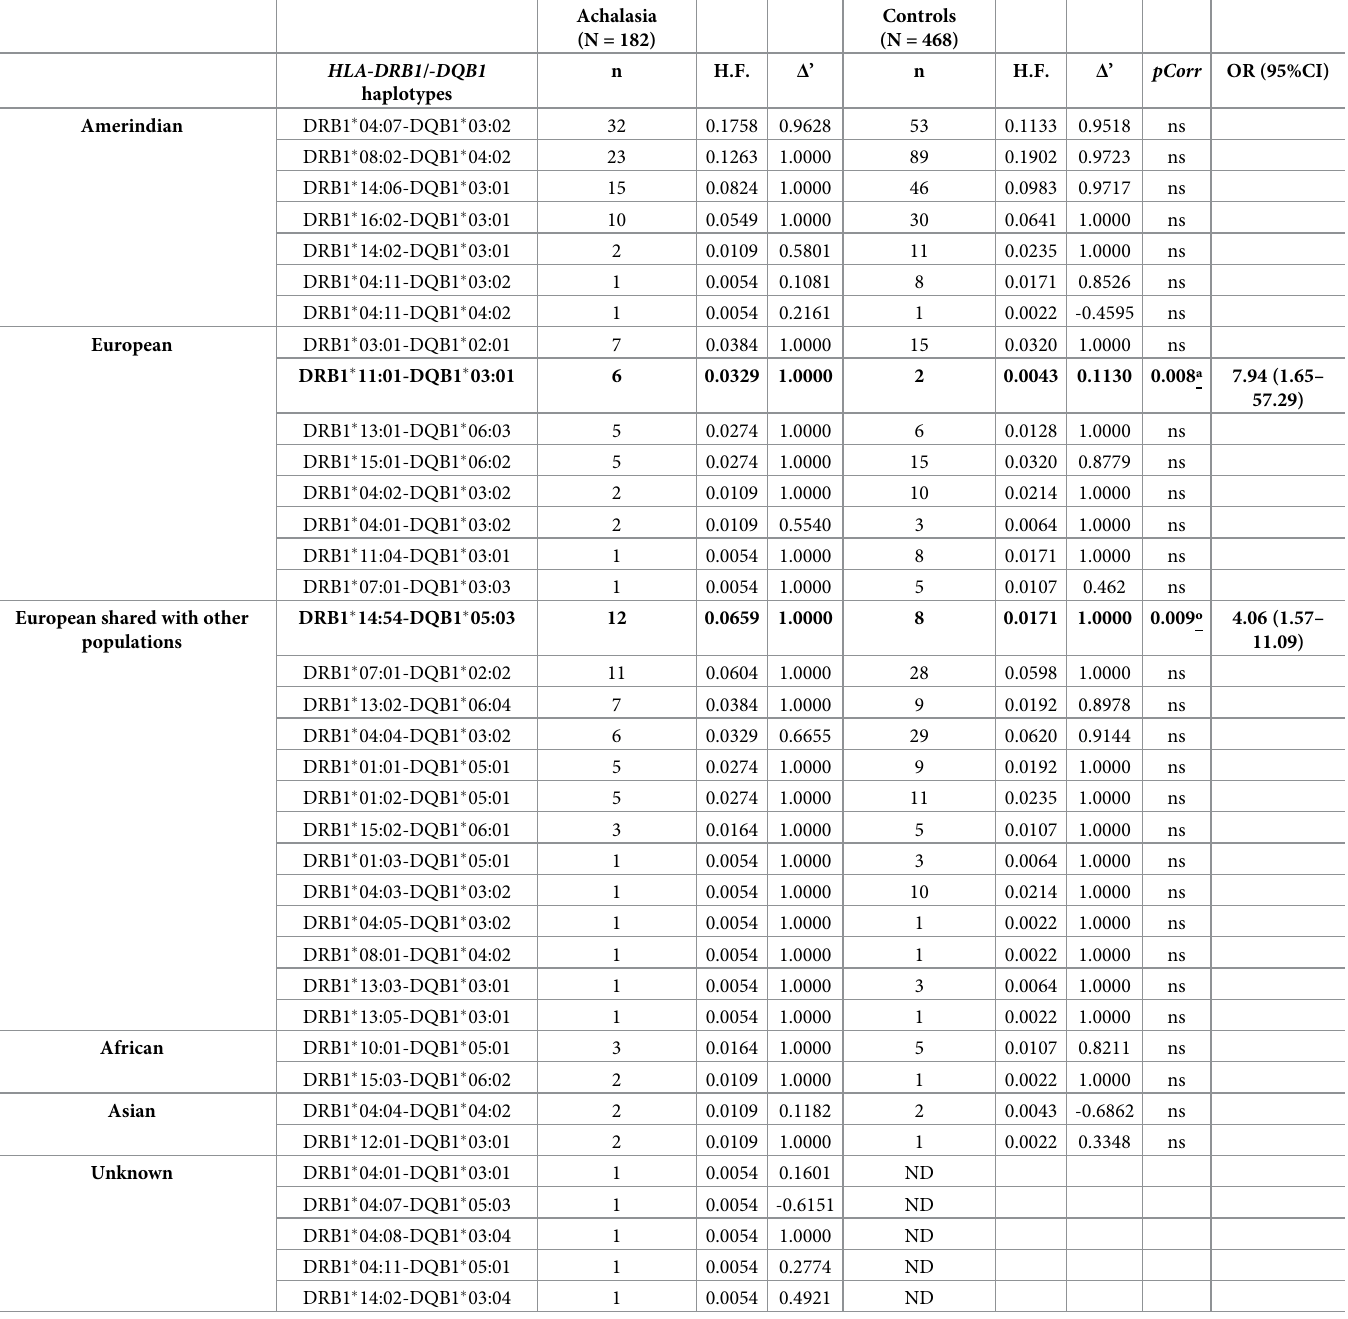
Table 5. Frequencies of HLA-DRB1/-DQB1 block in achalasia patients and healthy